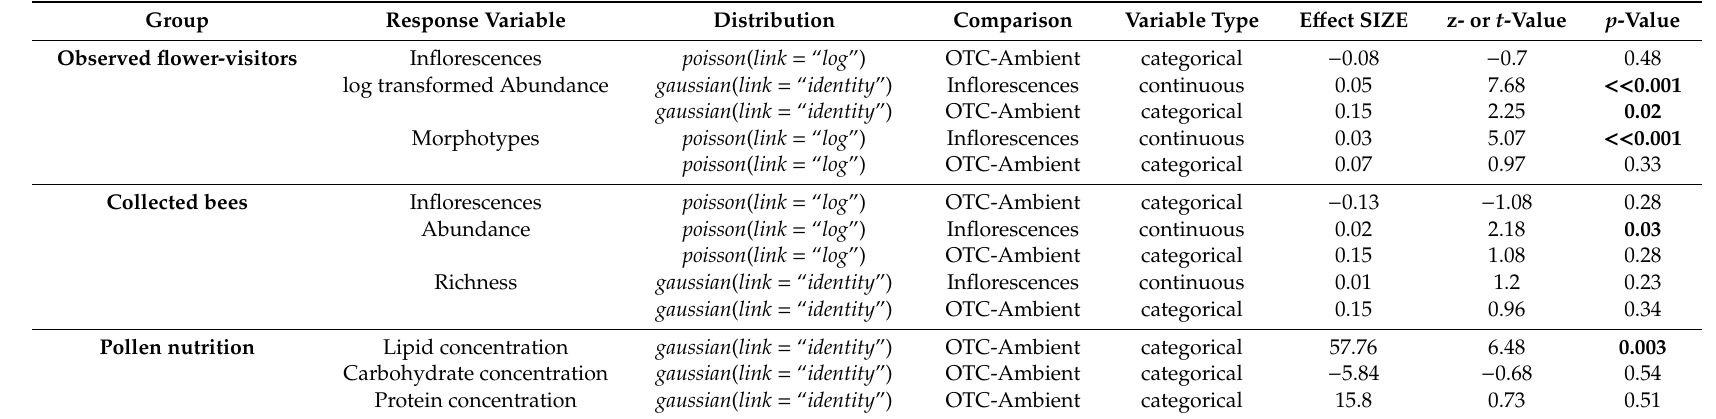
Table 1. General linear mixed e ff ects models (GLMMs) used to test for the e ff ects of treatment, observer type, and inflorescence number, with significant values in